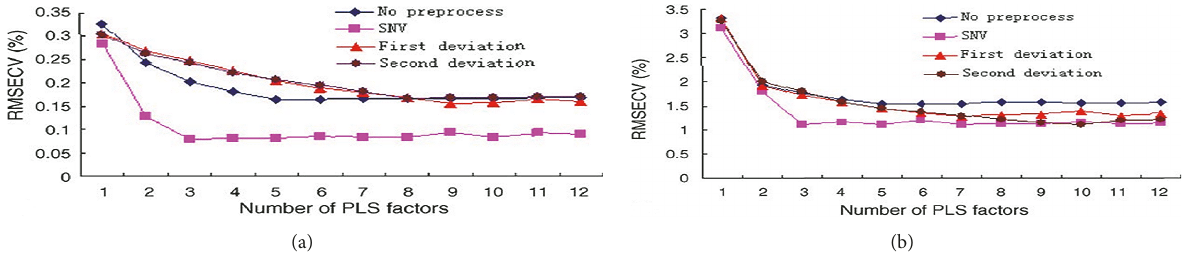
Figure 5: Optimized the best spectral process methods and number of PLS factors.